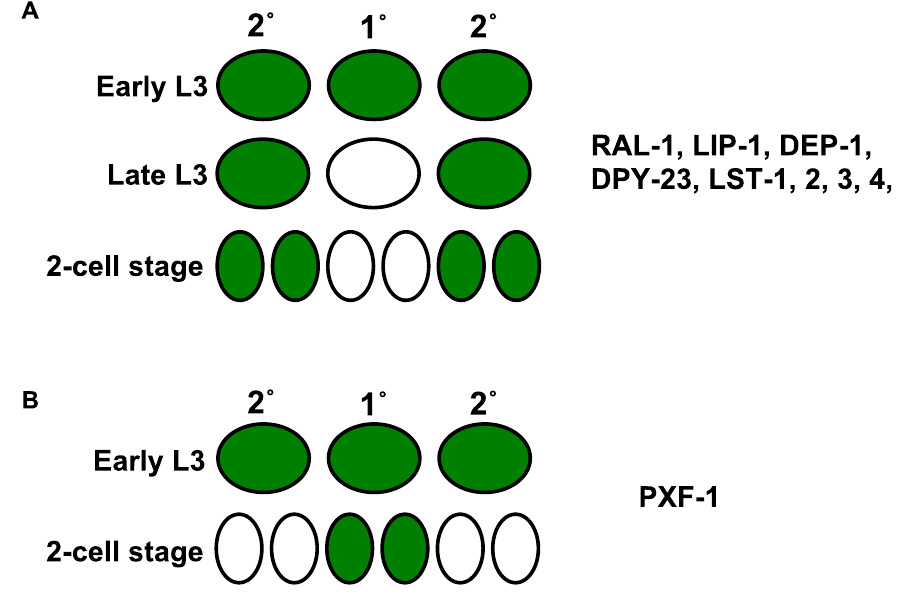
Figure 4. Reprogramming expression from transcriptional GFP reporters of either 2 ◦ -promoting/1 ◦ -antagonizing or 1 ◦ -promoting genes. Transcriptional reprogramming is shown by promoter GFP fusion in VPCs. ( A ) Transgenic promoters of 2 ◦ -promoting ral-1 and 1 ◦ -antagonizing Notch transcriptional targets lip-1 , dep-1 , dpy-23 , lst-1 , -2 , -3 , and -4 , express GFP in both presumptive 1 ◦ and 2 ◦ cells at early L3, before induction. After induction, GFP expression is reduced in 1 ◦ but persists in 2 ◦ lineages. ( B ) The transgenic promoter of 1 ◦ -promoting pxf-1 expresses GFP in presumptive 1 ◦ and 2 ◦ cells at early L3, before induction. After induction, GFP persists in the the 1 ◦ lineage but is reduced in the 2 ◦ lineage. Thus, expression of modulatory genes in the VPC fate patterning network are reprogrammed during the inductive process.